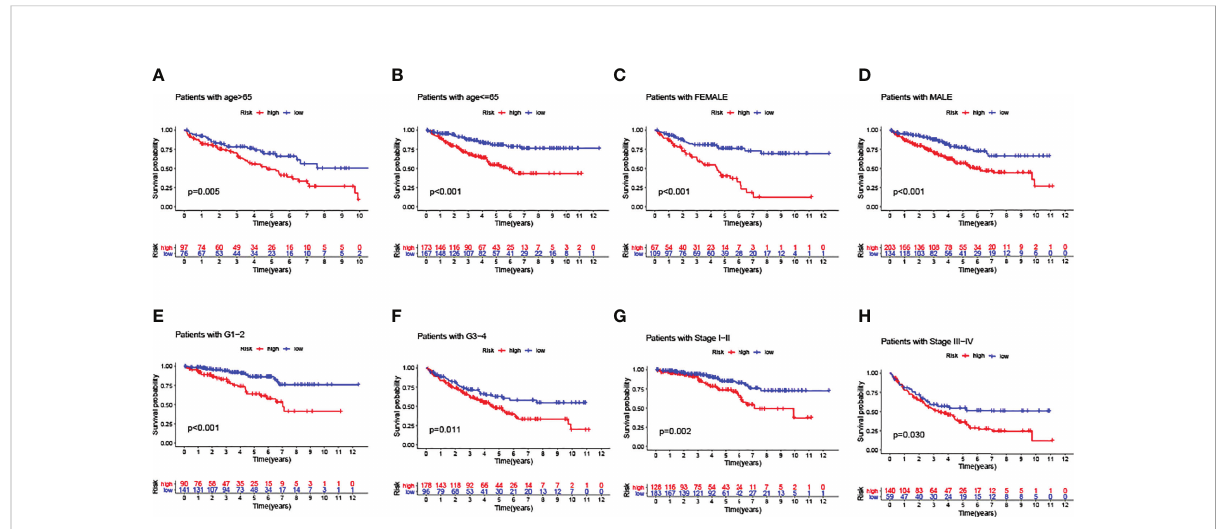
FIGURE 6 Predictive consistency analyses of GILncSig in populations with different clinical characteristics. (A, B) KM curves: Comparisons of OS between ccRCC patients with high and low risk, in old and young groups. (C, D) KM curves: Comparisons of OS between ccRCC patients with high and low risk, in male and female groups. (E, F) KM curves: Comparisons of OS between ccRCC patients with high and low risk, in pathologically early and advanced groups. (G, H) KM curves: Comparisons of OS between ccRCC patients with high and low risk, in clinically early and advanced